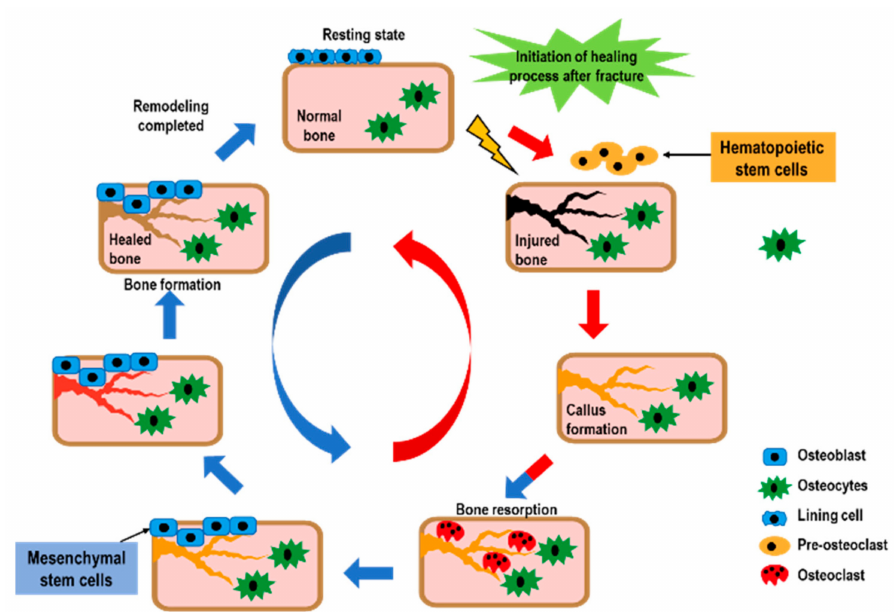
Figure 2. The bone healing process after a fracture. Bone remodeling after fracture is initiated by osteoclast activation, and it solubilizes the bone mineral and degrades the matrix. Osteoclasts originate from hematopoietic stem cells which fuse to form multinucleated cells (activated form of osteoclasts). Monocytes / macrophages remove debris, followed by a bone formation phase performed by osteoblasts, producing osteoid matrix which will